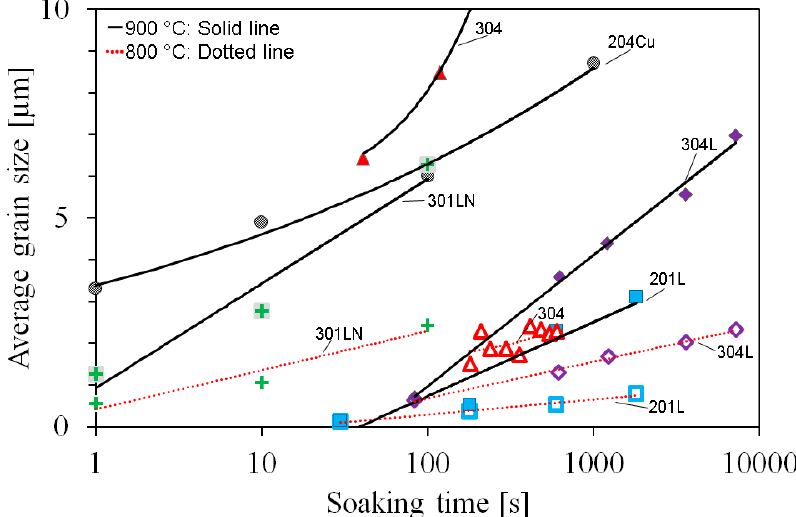
Figure 7. Grain growth of reversed grain size at 800 and 900 °C in 201L [67], 204Cu [82], 301LN [26], 304L [17,70] and 304 [11] ASSs.